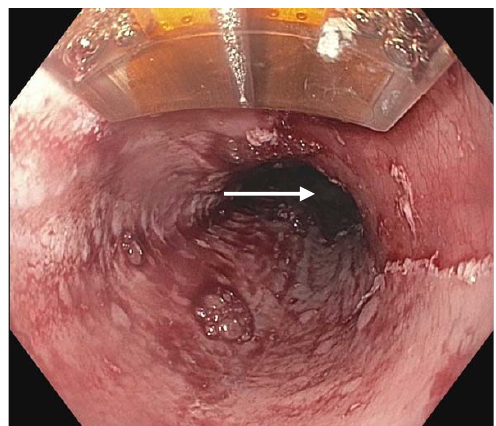
Figure 3. Radiofrequency ablation being applied using a probe toa dysplastic mucosal area (white arrow).